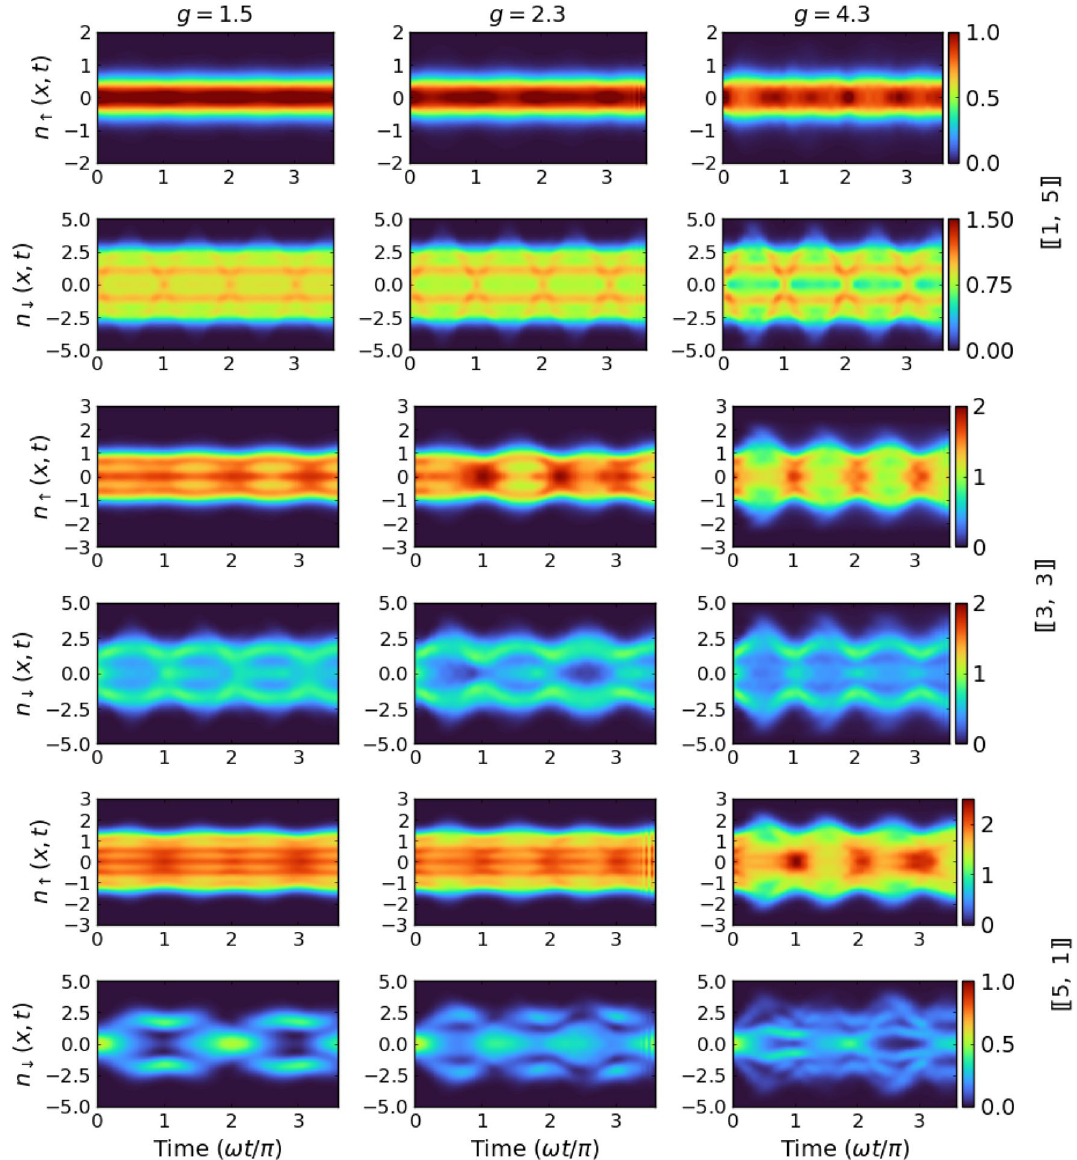
Figure 6. Time evolution of the single-particle density distributions n σ ( x , t ) for six-particle systems with different imbalances and interactions. Here, to keep correspondence with Fig. 5, mass ratio is fixed µ